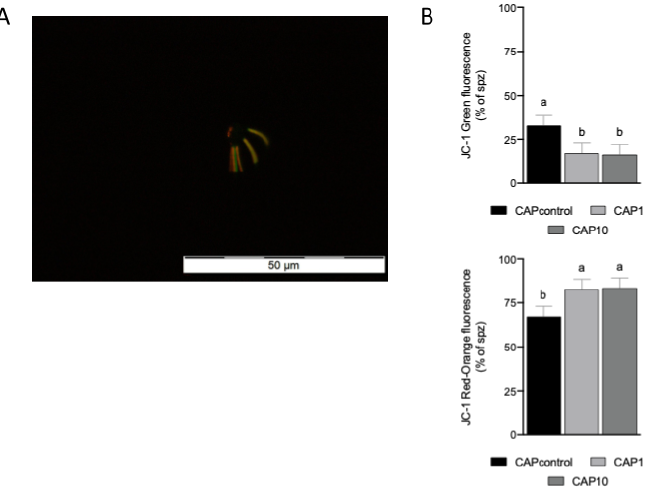
Figure 2. Effects of the mitochondria-targeted hydroxybenzoic acid derivative AntiOxBEN2 supple- mentation on mitochondrial membrane potential (MMP) of spermatozoa during the capacitation process. ( A ) Typical image of bovine spermatozoa stained with the florescent probe 5,5′,6,6′-tetra- chloro-1,1′,3,3′-tetraethylbenzimidazolcarbocyanine iodide (JC-1, Invitrogen), as an indicator of mi- tochondrial activity. Labeled sperm showed a clear midpiece-only staining pattern; the midpiece was either homogeneously green (low DΨmit) or with speckles of yellow/orange/red (high DΨmit). ( B ) Percentage of spermatozoa emitting yellow/orange/red (high DΨmit) (down panel) and green (low DΨmit) (upper panel) fluorescence after capacitation in the presence or absence of AntiOx- BEN2 (1 and 10 µM) supplementation. The data (mean ± SEM, 6 replicates) obtained with AntiOx- BEN2 were compared to control using the mixed procedure/PDIFF of SAS. Significant differences between the indicated conditions are marked by different letters (a ≠ b, p < 0.05). CAPcontrol: capac- itation medium without supplementation; CAP1: capacitation medium supplemented with 1 µM of AntiOxBEN2; CAP10: capacitation medium supplemented with 10 µM of AntiOxBEN2. 3.4. AntiOxBEN2 Dose-Dependently Increased Sperm Cellular (Basal) Oxygen Consumption Mitochondrial oxygen consumption is a sensitive indicator of spermatozoa health since it is positively correlated with traditional measures of sperm function, including motility and viability [32]. Consequently, the impact of AntiOxBEN2 on mitochondrial oxygen consumption of spermatozoa during capacitation was measured through varia- tions on cellular oxygen consumption rate (OCR) using the Seahorse XF-96 Extracellular Flux Analyzer. Interestingly, AntiOxBEN2 dose-dependently increased spermatozoa ba- sal OCR (control = 21.7 ± 2.88 pmol/min; CAP1 = 25.1 ± 3.05 pmol/min; and CAP10 = 33.9 ± 2.88 pmol/min, p = 0.004 and p = 0.04, respectively) (Figure 3A). Similar to MMP meas- urements, a bull effect was not observed for cellular OCR measurements ( p > 0.05).